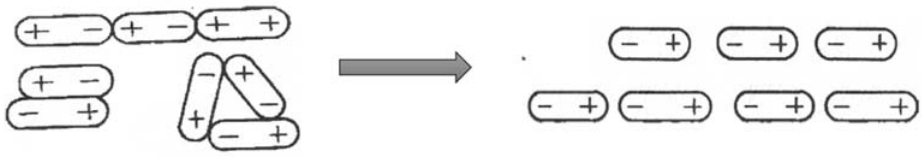
Figure 1. E ff ect of the magnetic field in water molecules Figure 1. Effect of the magnetic field in water molecules [10].